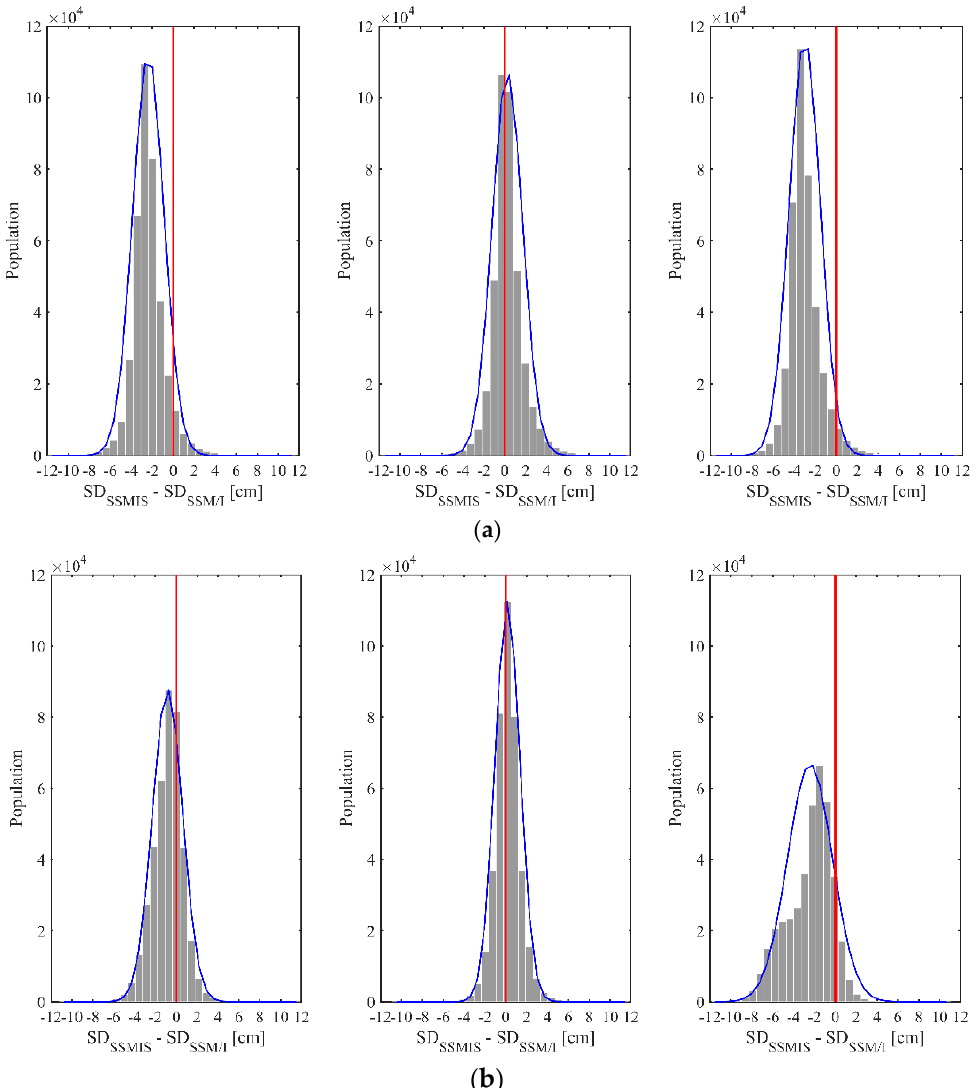
Figure 16. Scatter plots of snow depth estimated with the same algorithm but different satellite observations. ( a ) Dual-channel algorithm; ( b ) multichannel algorithm. The Tbs calibrated with group 1 and group 2 equations were denoted by F13CS (calibrated in snow-covered areas) and F13CA (calibrated in all areas), respectively. Left: F17 vs. F13; middle: F17 vs. F13CS; right: F17 vs. F13CA.